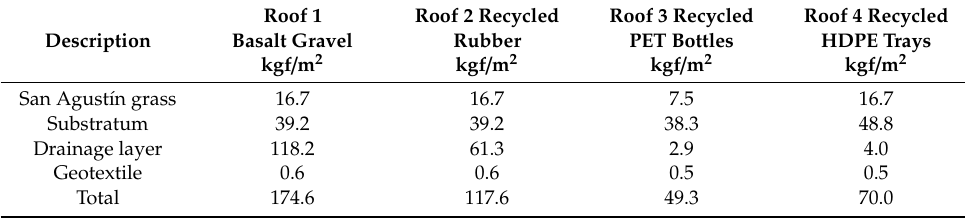
Table 5. Weights per area (m 2 ) for components of the studied green roof